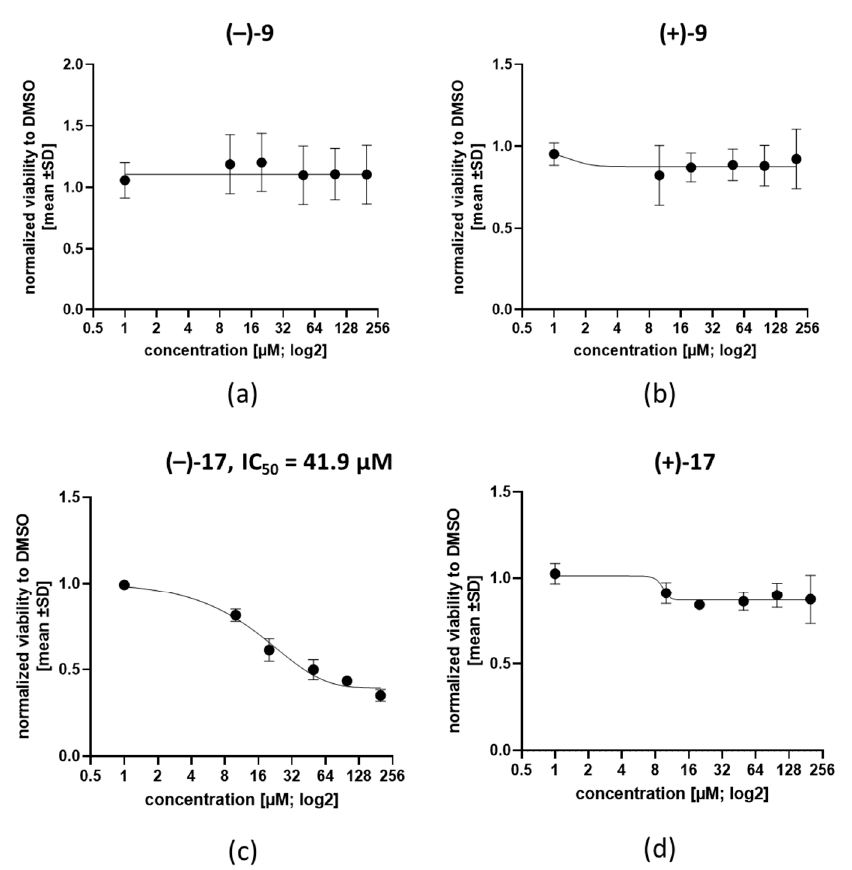
Figure 5. Low cytotoxicity of enantiomers on hematopoietic HEL cells. HEL cells were treated with (–)- 9 ( a ), (+)- 9 ( b ), (–)- 17 ( c ), and (+)- 17 ( d ) at concentrations of 1, 10, 20, 50, 100 and 200 µM for 72 h or DMSO as control. All data were normalized to the DMSO control and shown as mean ± SD. Graphs show a combination of three independent experiments.